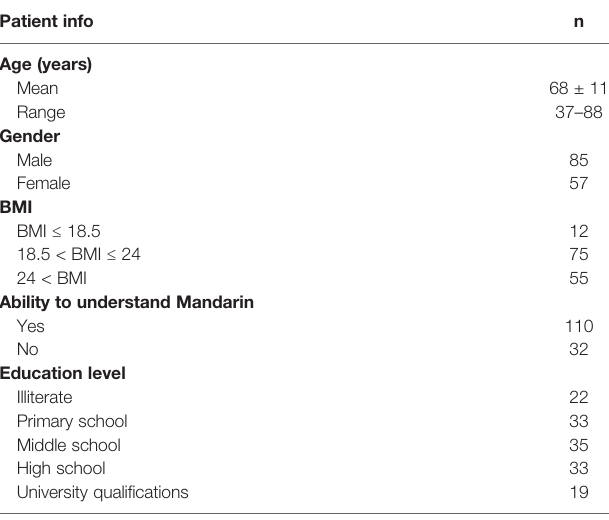
TABLE 1 | Clinical characteristics for patients (n = 142).